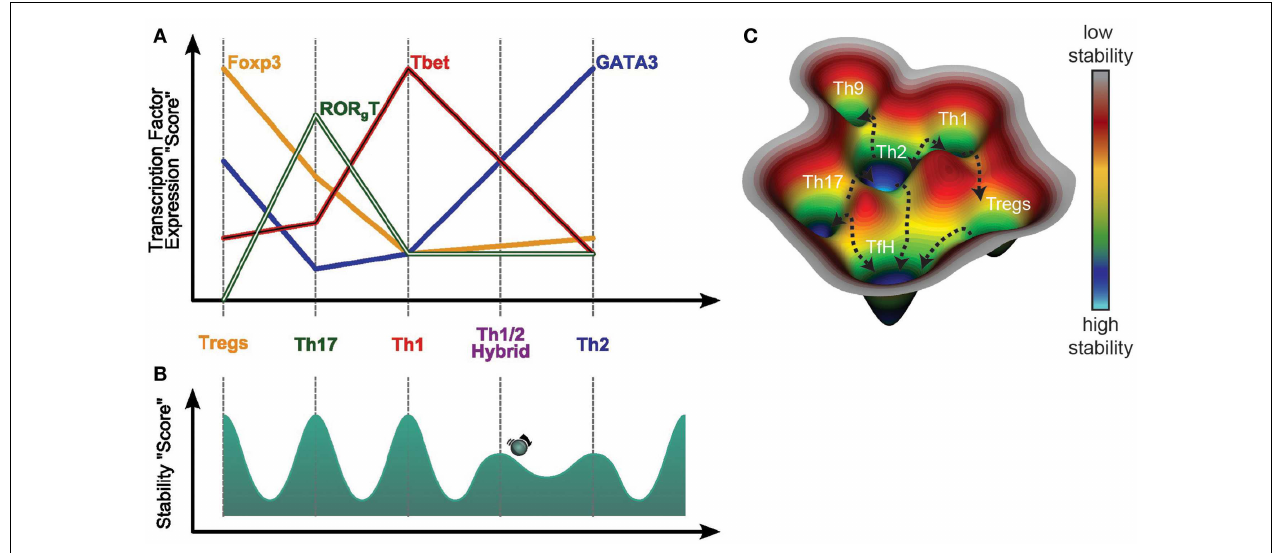
participating in the fate determination of each subset. For example, the Th1/Th2 population has been shown to present intermediary level of gata-3 andT-bet expression as compared respectively toTh2 andTh1. Through similar transcriptomic approach, generalised on all theT helper subsets, it would thus be possible to define a ration of transcription factors necessary to enable the switch from one subset to another. (C) The plasticity of theT helper subsets is represented in a conceptual 3D potential landscape and illustrate that the diverse repertoire ofT helper cell subsets, and its important plasticity, enable the host to have an array of fine-tuned adaptive responses to both control the parasite development and avoid and repair pathology caused by the worm